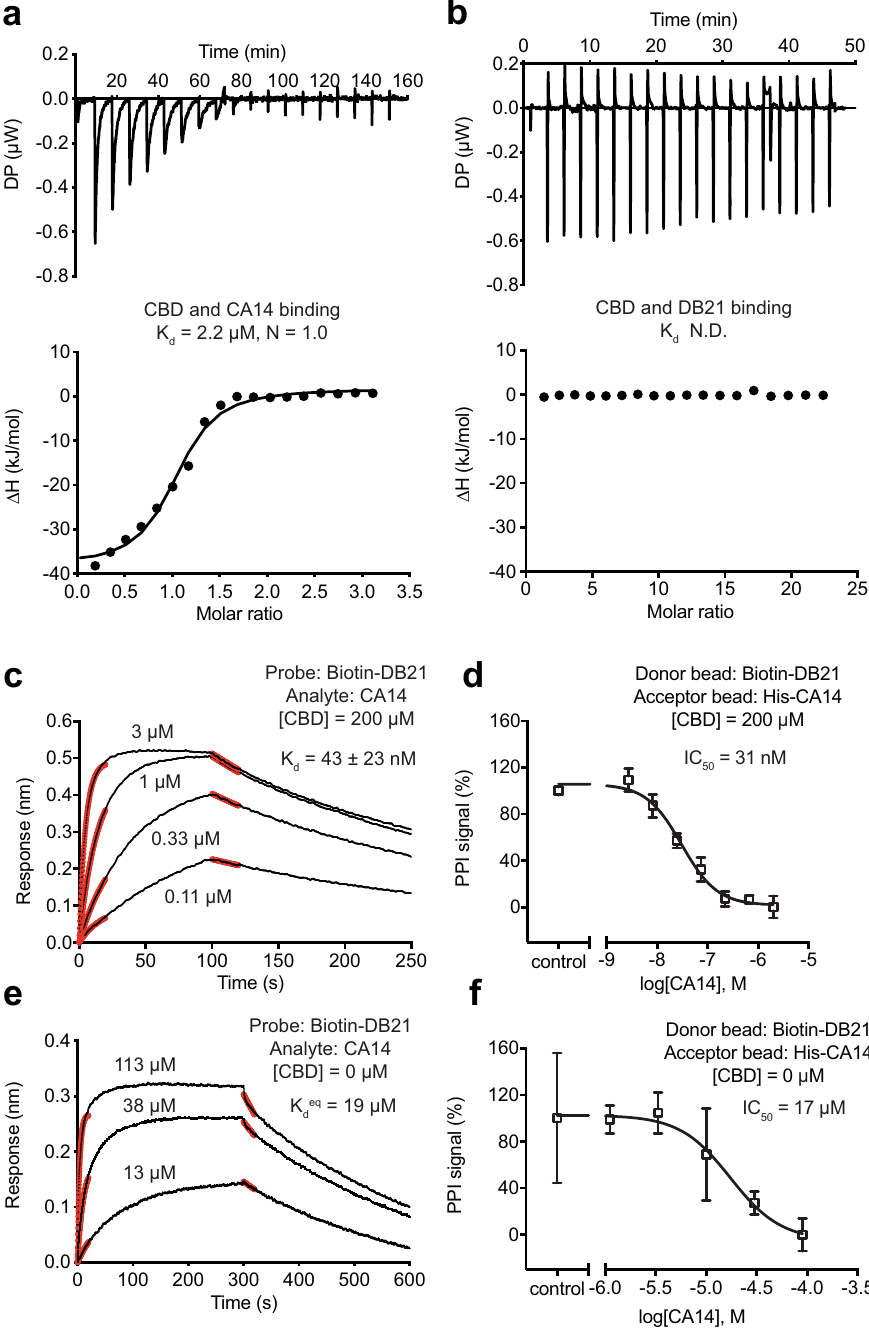
Fig. 3 Quantitative analysis of CBD dual-nanobody sensor. a , b CBD binding to CA14 and DB21 measured by isothermal titration calorimetry (ITC). Source data are provided as a Source Data fi le. c , e BioLayer interferometry (BLI) measurements of CA14 and DB21 interaction in the presence and absence of CBD at a saturating concentration. Black lines represent the kinetics of association and dissociation of CA14 with biotinylated DB21 immobilized on the probe. Red lines represent curve fi tting at the initial phase of association and dissociation. For CA14 – DB21 interaction without CBD, there was a discrepancy between the K d values determined by kinetics (3.0 ± 0.8 μ M) and equilibrium measurements. The latter is consistent with the result obtained in AlphaScreen assays. K d , dissociation constant. Source data are provided as a Source Data fi le. d , f AlphaScreen competition assays for assessing DB21 binding to CA14 with and without CBD. Data were presented as mean ± s.d. of n = 3 biologically independent samples. IC 50 , half-maximum inhibitory concentration. Source data are provided as a Source Data fi